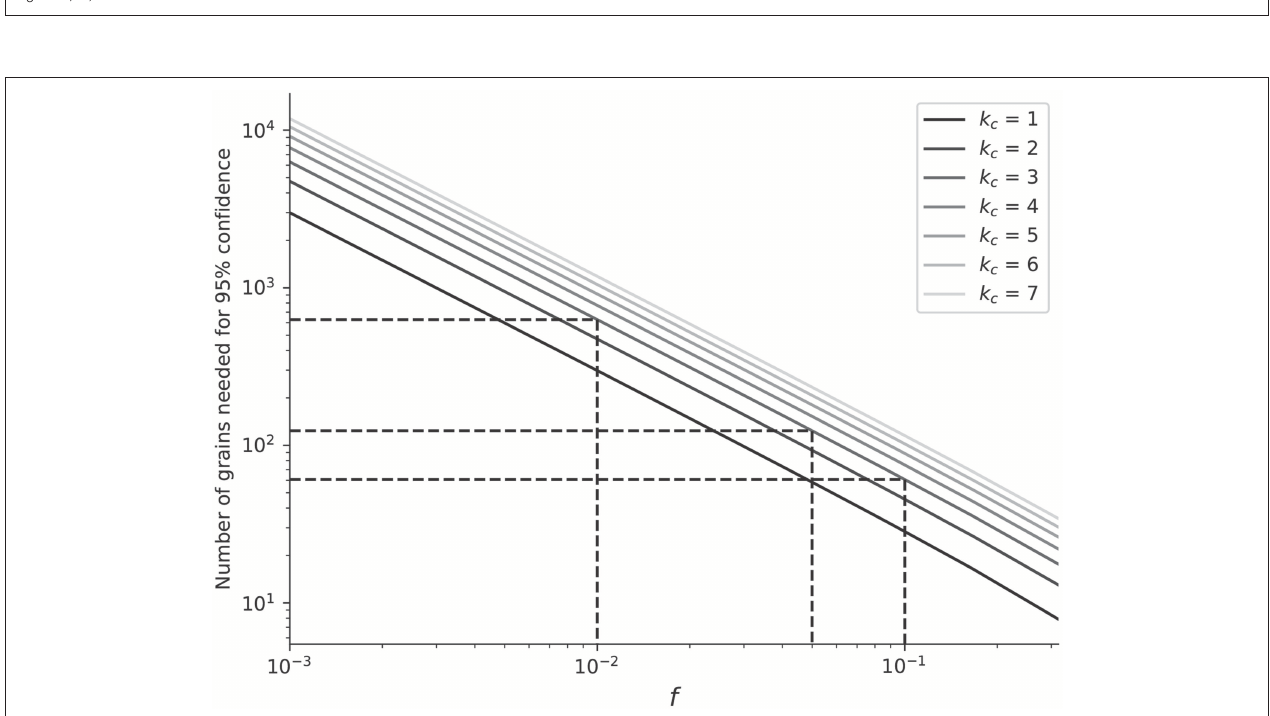
FIGURE 3 | How many grains should be dated to be 95% confident that we would date at least k c grains from the youngest source of grains? The solid lines provide this recommendation as a function of f , the fraction of dateable mineral grains from the youngest source. In practice, it is unlikely that this quantity can be known. The dashed lines represent specific recommendations for if f = 10, 5, and 1%. In 95% of cases where you date ∼ 60, ∼ 120, and ∼ 630 grains, at least 3 grains will be dated from sources that contributed 10, 5, and 1% of all the dateable minerals.